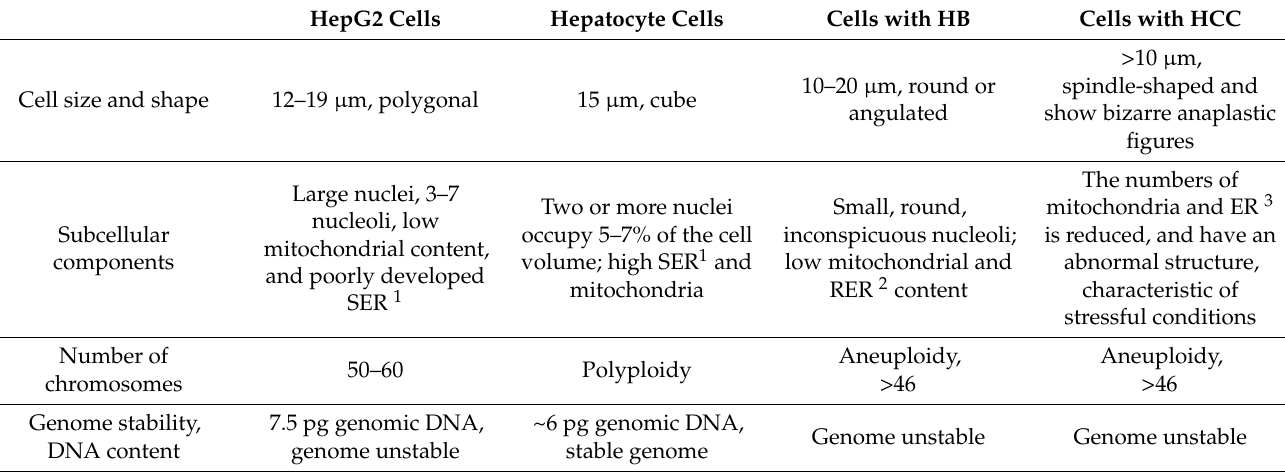
Table 2. Comparison of HepG2 cells with hepatocytes and cells with HCC and